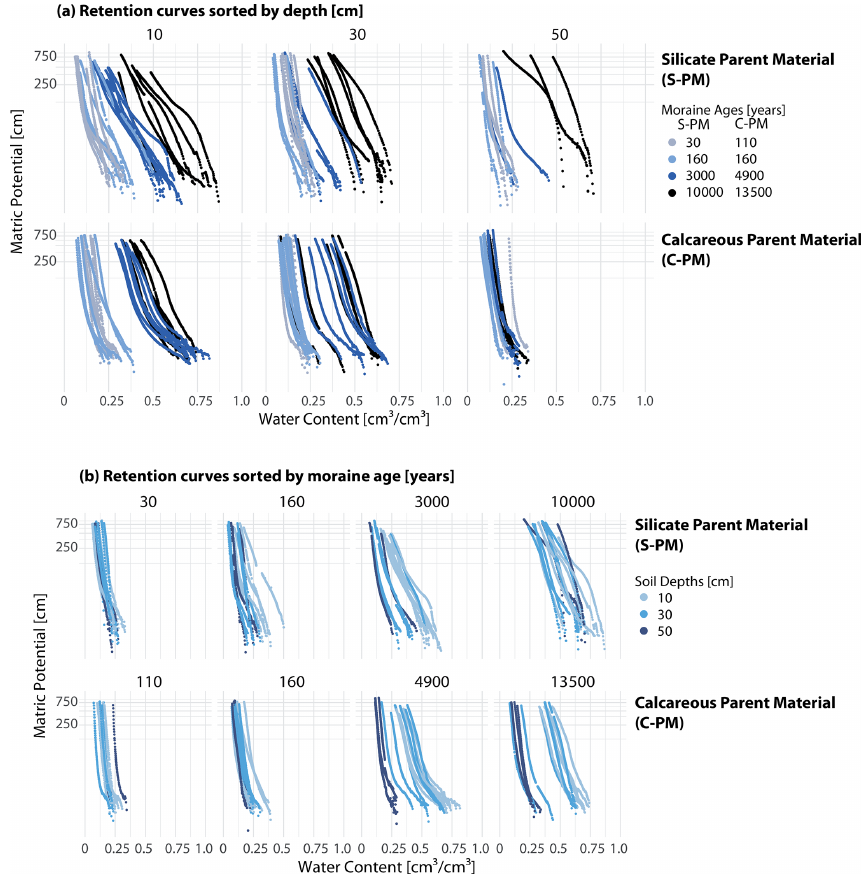
Figure 7. Development of retention curves at 10, 30, and 50cm over 10 millennia on silicate (S-PM) and calcareous (C-PM) parent material sorted by depth (a) and moraine age (b)